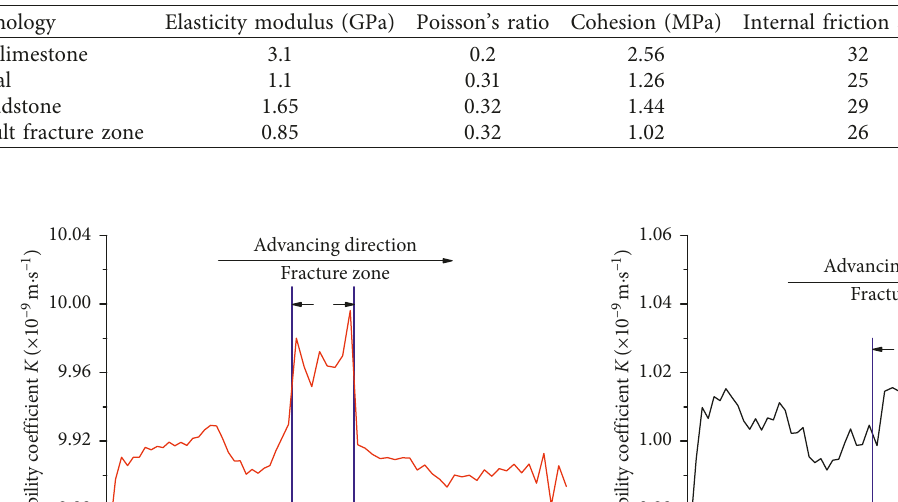
Table 4: Mechanical parameters of each rock stratum in numerical calculation.